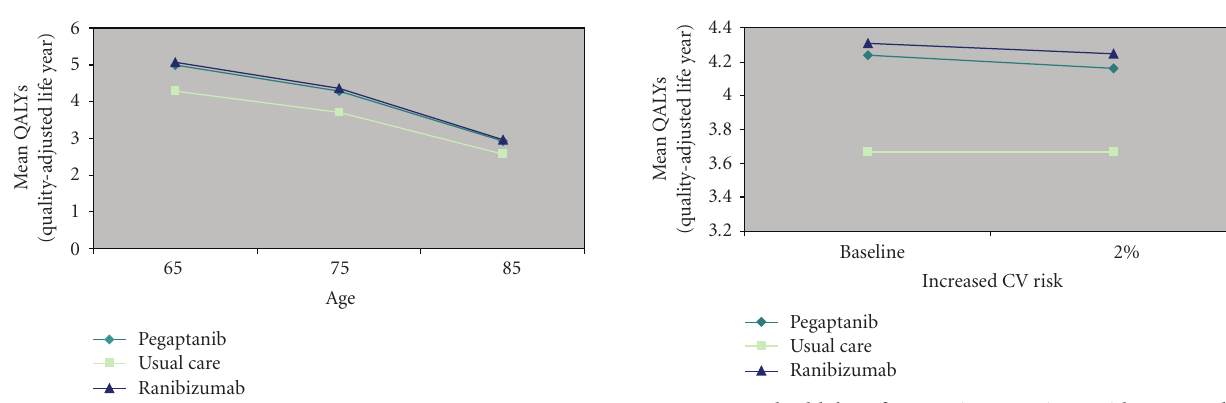
Figure 2: Net health benefits accruing to patients with neovascular age-related macular degeneration when using vascular endothelial growth factor inhibitors according to age (years) at treatment initiation.